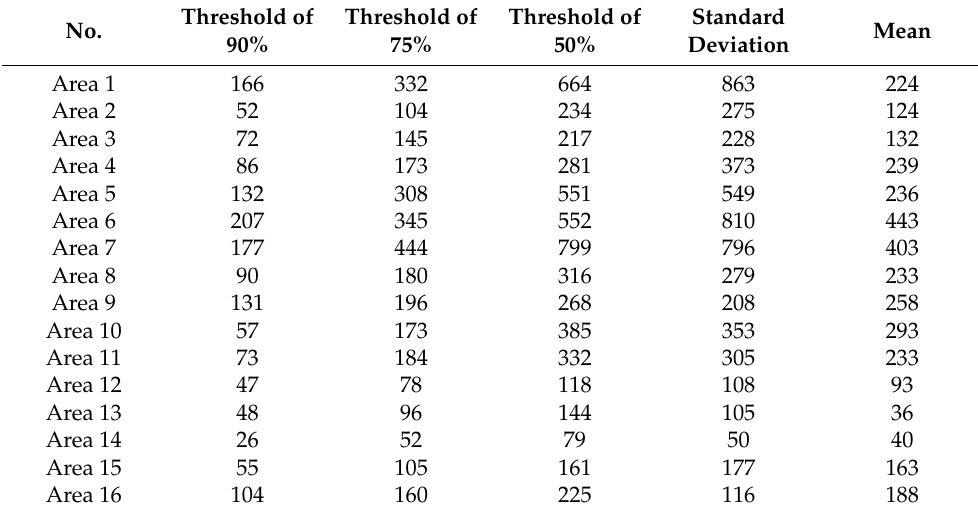
Table 4. Probability-based total sea traffic percentage